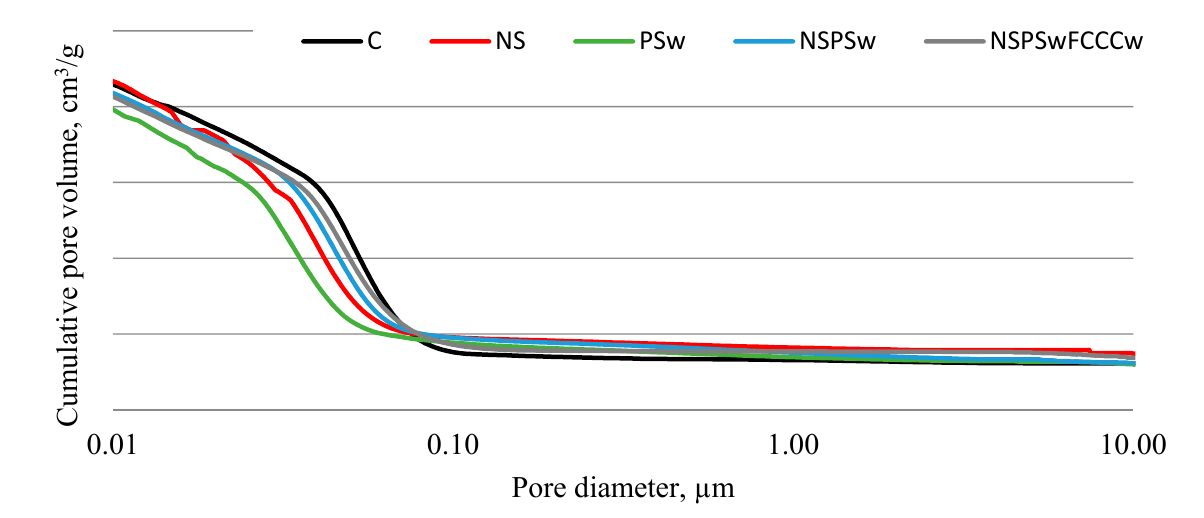
Figure 10. Results of cumulative pore volume in hardened cement paste. Table 3. Mercury intrusion porosimetry (MIP) results in terms of pore diameters (average, me- dian), total surface, accessible and total porosity.